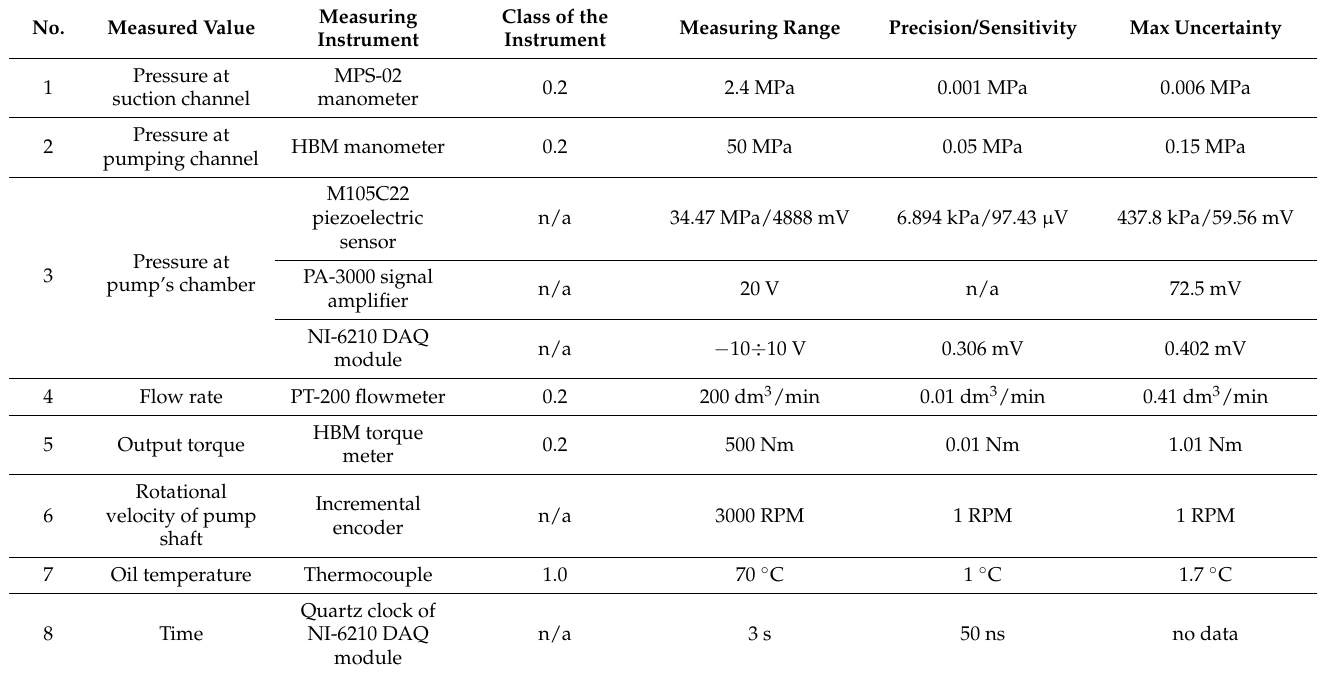
Table 1. Specification of the measurement equipment used in the test